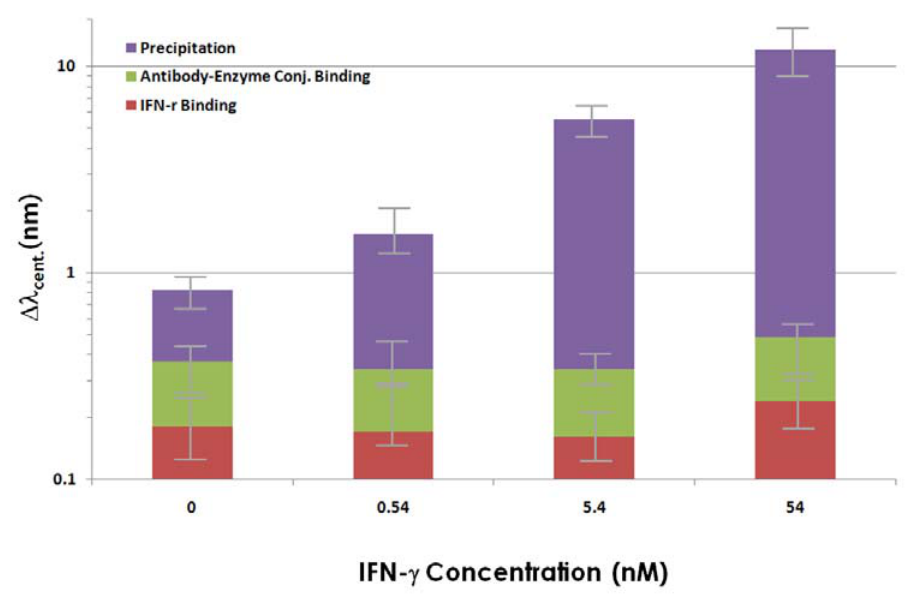
Figure 4. Centroid shifts in the LSPR band after various concentrations of IFN-  were bound to anti- IFN-  5 and after the enzyme-catalyzed precipitation reactions, which significantly amplified the signal change. Each plotted value was averaged from the five identical experiments using different NI chips for each concentration and the error bars represent the standard